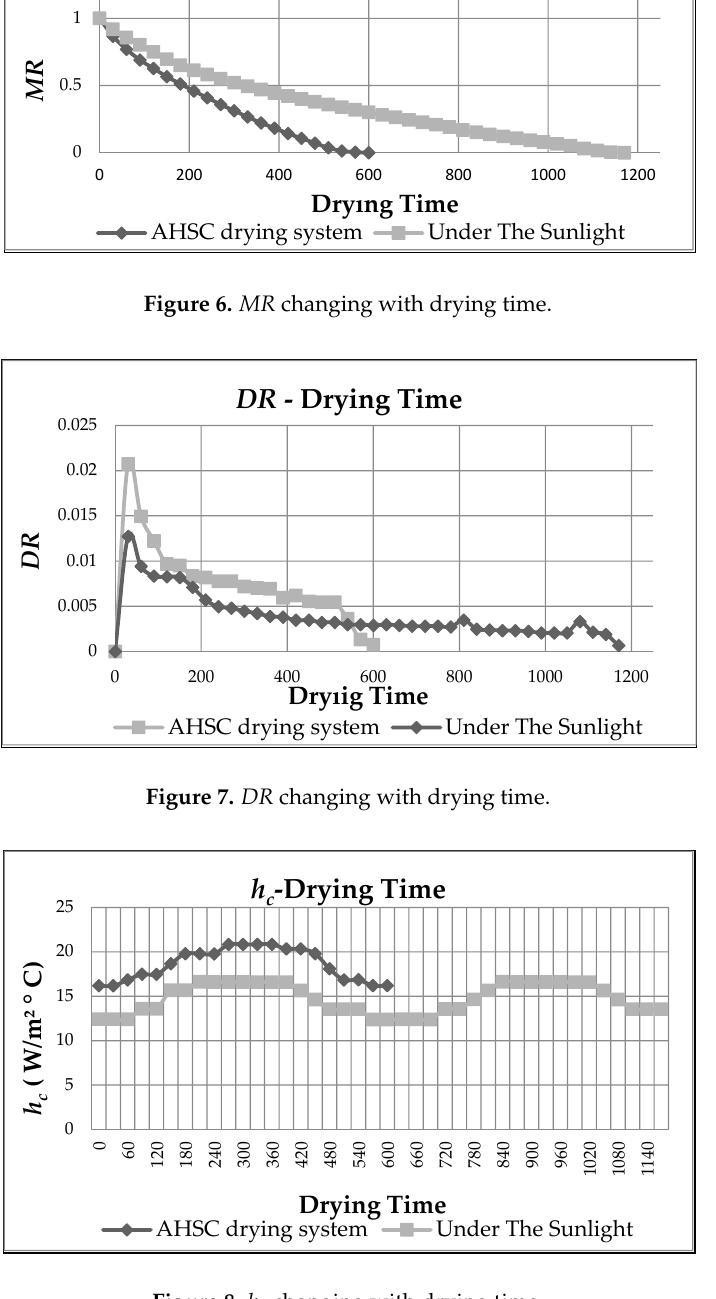
Table 5. Error rates for SVM regression.